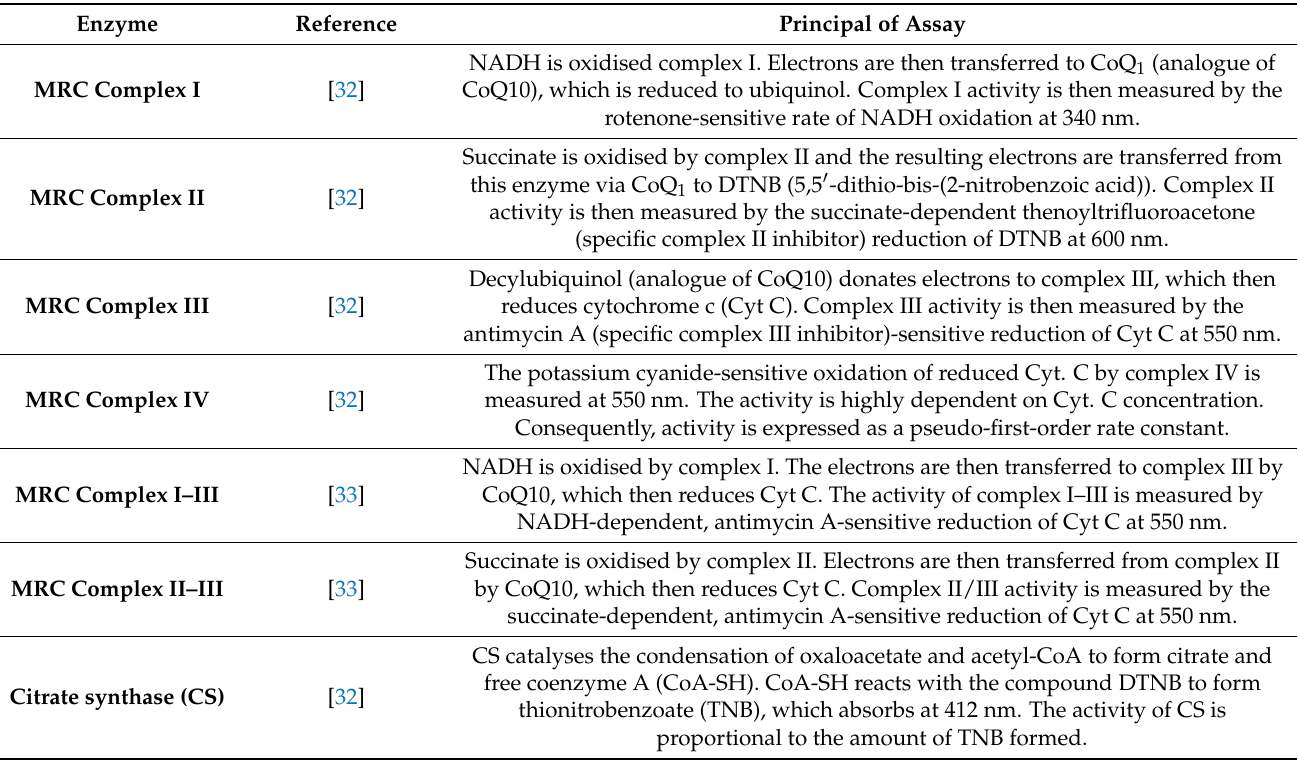
Table 1. Details of spectrophotometric enzyme assays used to determine mitochondrial respiratory chain (MRC) enzymes and citrate synthase (CS)